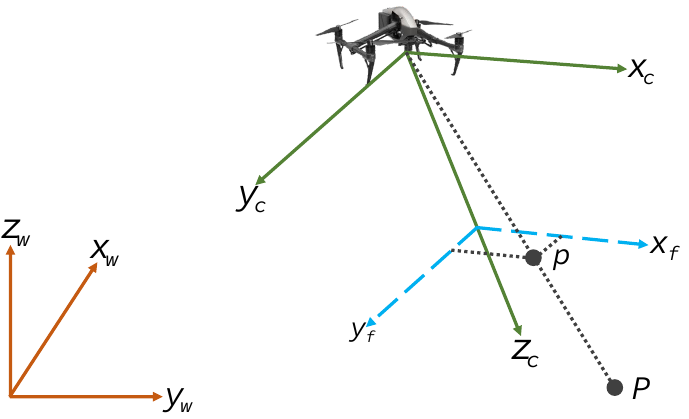
Figure 3. Target geolocation